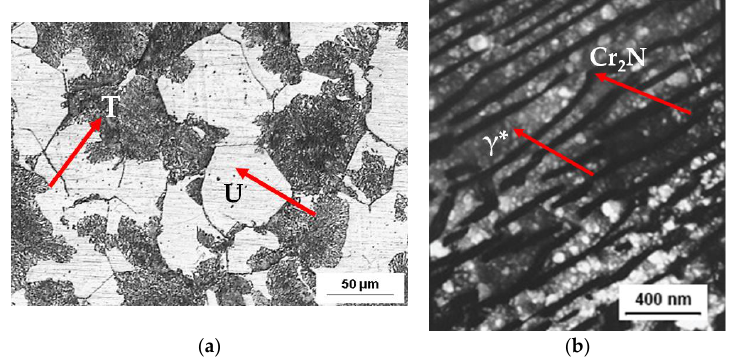
Figure 6. Cellular precipitation after the heat treatment ( a ). Arrows indicate transformed (T) and untransformed (U) zones. SEM micrograph showing details of the lamellar structure made of γ* and Cr 2 N ( b ).